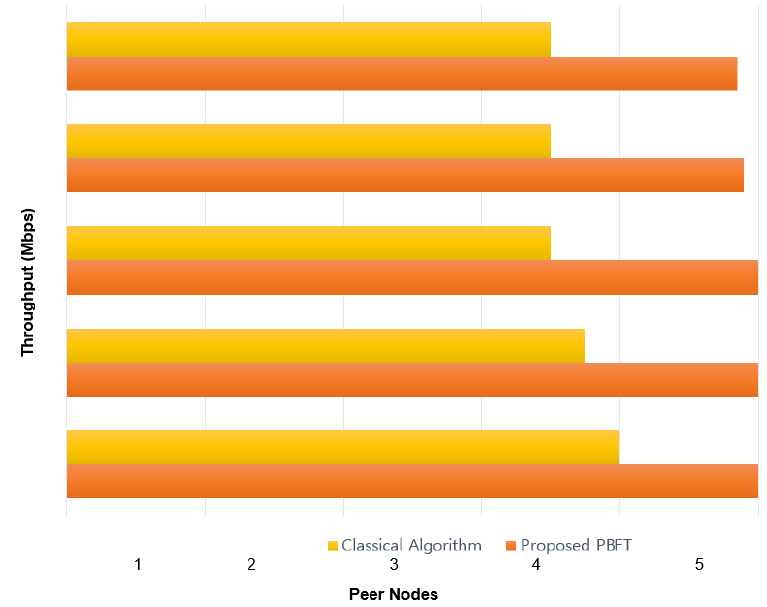
Figure 3. Throughput Comparison between Classical BFT and Proposed PBFT.